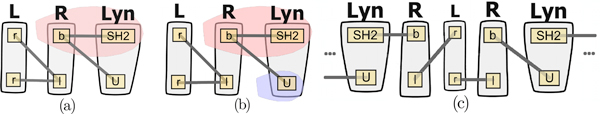
Lyn-binding debugging. Reduced view: Ligand notation shortened to L and Rec shortened to R. If the user programs the rule that binds Lyn to Rec incorrectly (see Table 2), the corresponding contact map in (a) is missing the rule context information. The correct binding leads instead to the visualization in (b); the presence of the blue bubble set alerted the researcher to the difference and allowed them to debug their RBM. The incorrect formulation would allow at run time for the creation of the infinitely binding chain shown in (c).